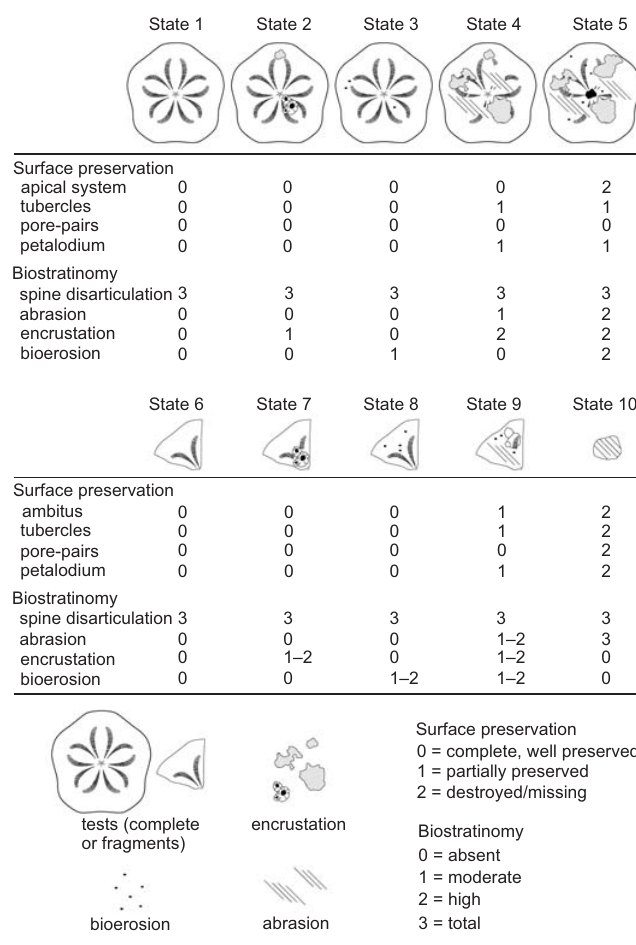
Fig. 6. Taphonomic gradient recognized on complete tests and fragments of clypeasteroid echinoids by using the qualitative analysis of the surface